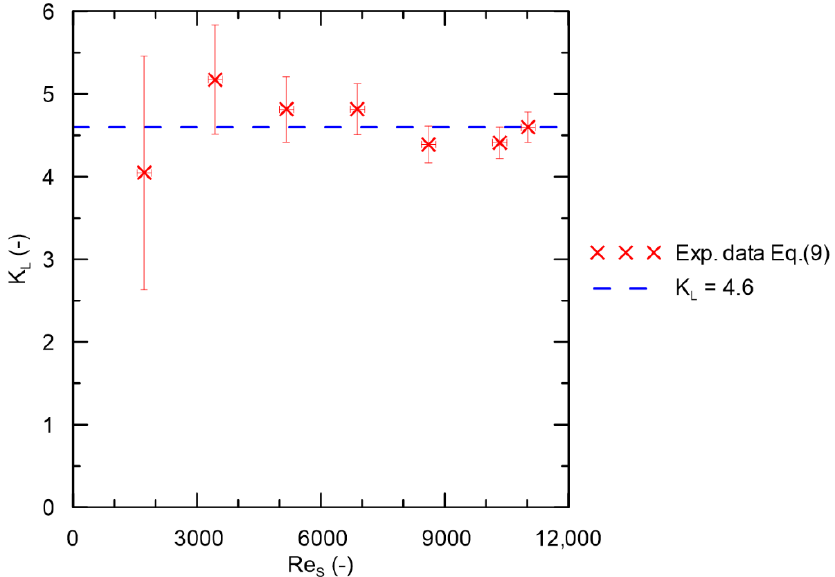
Figure 3. Minor loss coefficient on the shell side 𝐾 (cid:3013) as a function of the Reynolds